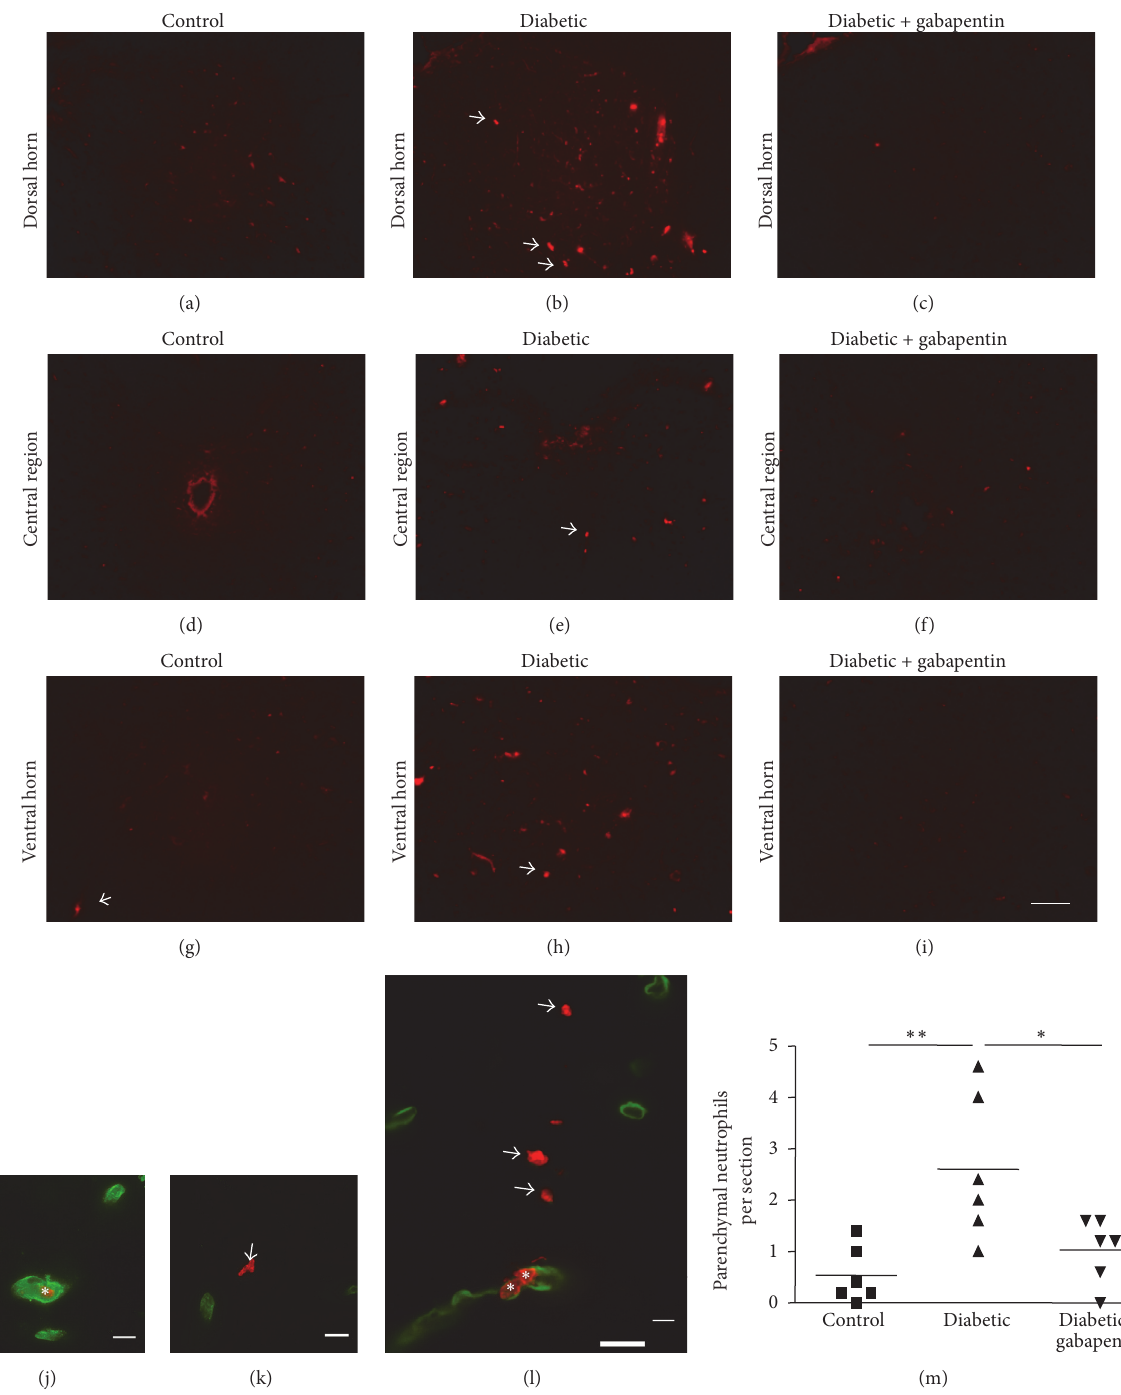
Figure 4: Diabetes is associated with an increase in neutrophil numbers within the spinal cord parenchyma, which is ameliorated with gabapentin treatment. (a–i) There is an increase in antineutrophil immunoreactivity within the dorsal horn (a–c), central region (d–f), and ventral horns (g–i) of untreated diabetic rats (arrows, (b), (e), and (h), scale bar represents 100 𝜇 m.). Dual immunofluorescence with antilaminin (green) to label blood vessels reveals the presence of intraluminal (asterisks, (j) and (l)) and parenchymal neutrophils (arrows, (k)and(l)).Onlyparenchymalneutrophils(i.e.,thosenotassociatedwithavessel)werecounted(m)andrevealedanincreaseinneutrophilsin the spinal cord of untreated diabetic rats and revealed that gabapentin treatment reduced the numbers to near-control levels ((m), ∗ 𝑝 < 0.05 , ∗∗ 𝑝 < 0.01 in a 1-way ANOVA with Bonferroni post hoc tests. 𝑛 = 6